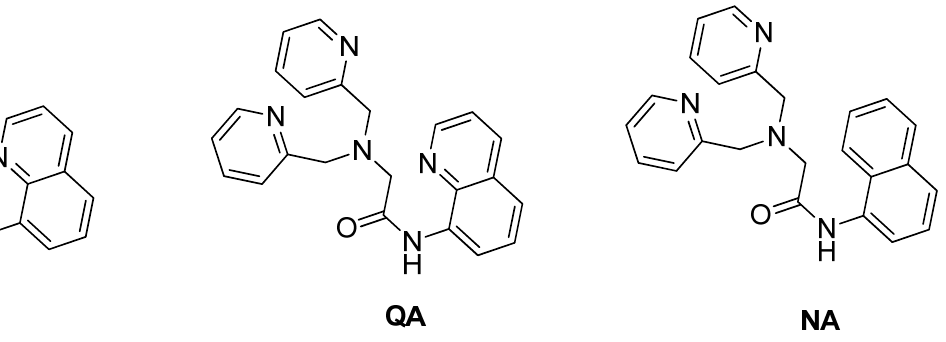
Figure 8. The structures of QP, QA, and NA.